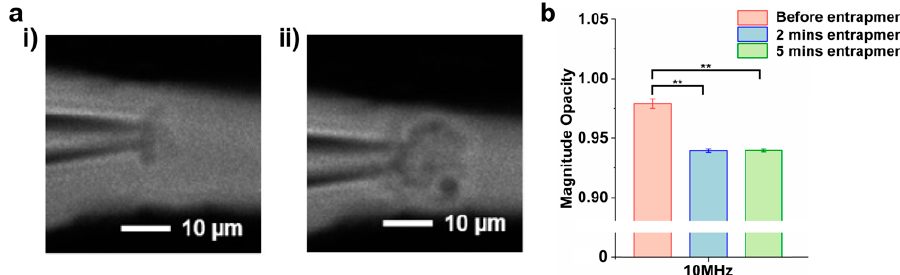
Figure 2. ( a ) Microscopic images of liposome entrapment for ( i ) 2 min, with the average number of trapped vesicles as 2.2 × 10 6 , and ( ii ) 5 min, with the average number of trapped vesicles as 5.4 × 10 6 . ( b ) The magnitude opacity comparison among empty pipette (before entrapment) and liposome clusters extracted at two different time intervals at 10 MHz. (** p < 0.05, n = 3).